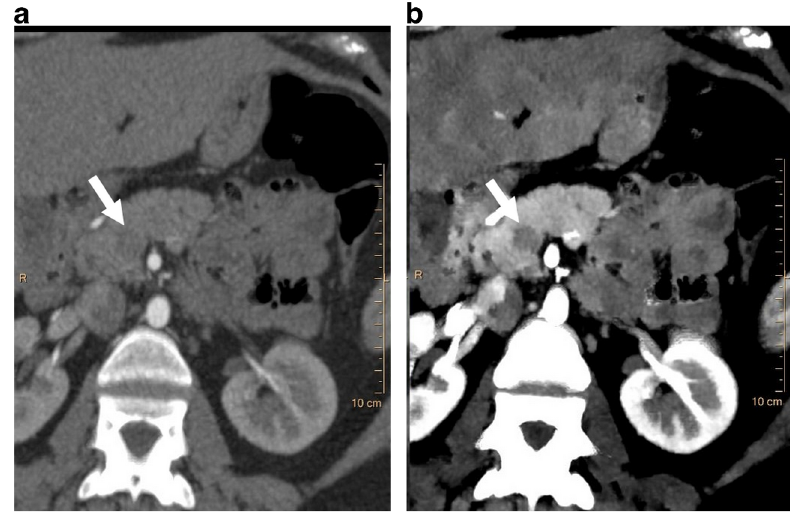
Fig. 5 Improved lesion conspicuousness. ( a ) Axial 120- kVp routine diagnostic CT image through the upper abdomen shows a vague ill-defined hypoattenuating lesion in the pancreatic head ( arrow ). ( b ) 50- keV VMI at the same level shows excellent contrast opacification of the pancreas, with much improved conspicuity of the hypoattenuating pancreatic head